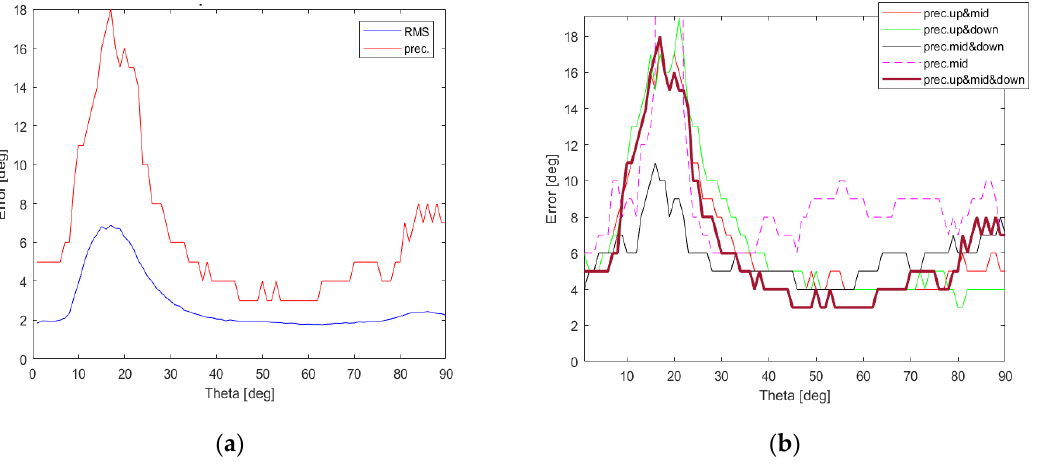
Figure 12. RMSE and precision values calculated using the proposed detailed DoA testing method, which involves all elevation angles during testing process, for the generalized PPCC-MCP algo- rithm relying on all possible steering vectors { V n up , V n mid , V n down } ( a ) together with precision value comparison for combinations of sets giving the most accurate results ( b ).